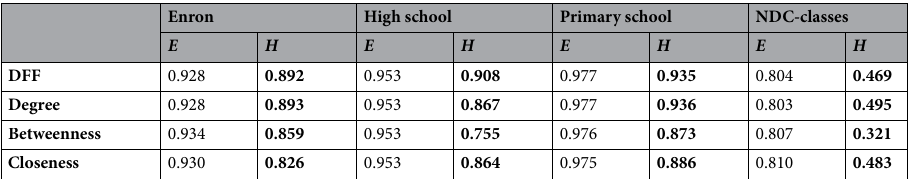
Table 2. Area under the size of giant component curves in Fig. 1 for edges ( E ) and higher-order interactions ( H ). The smaller values means the better performance. The cells for the best (smallest) value in each row for each dataset is typed